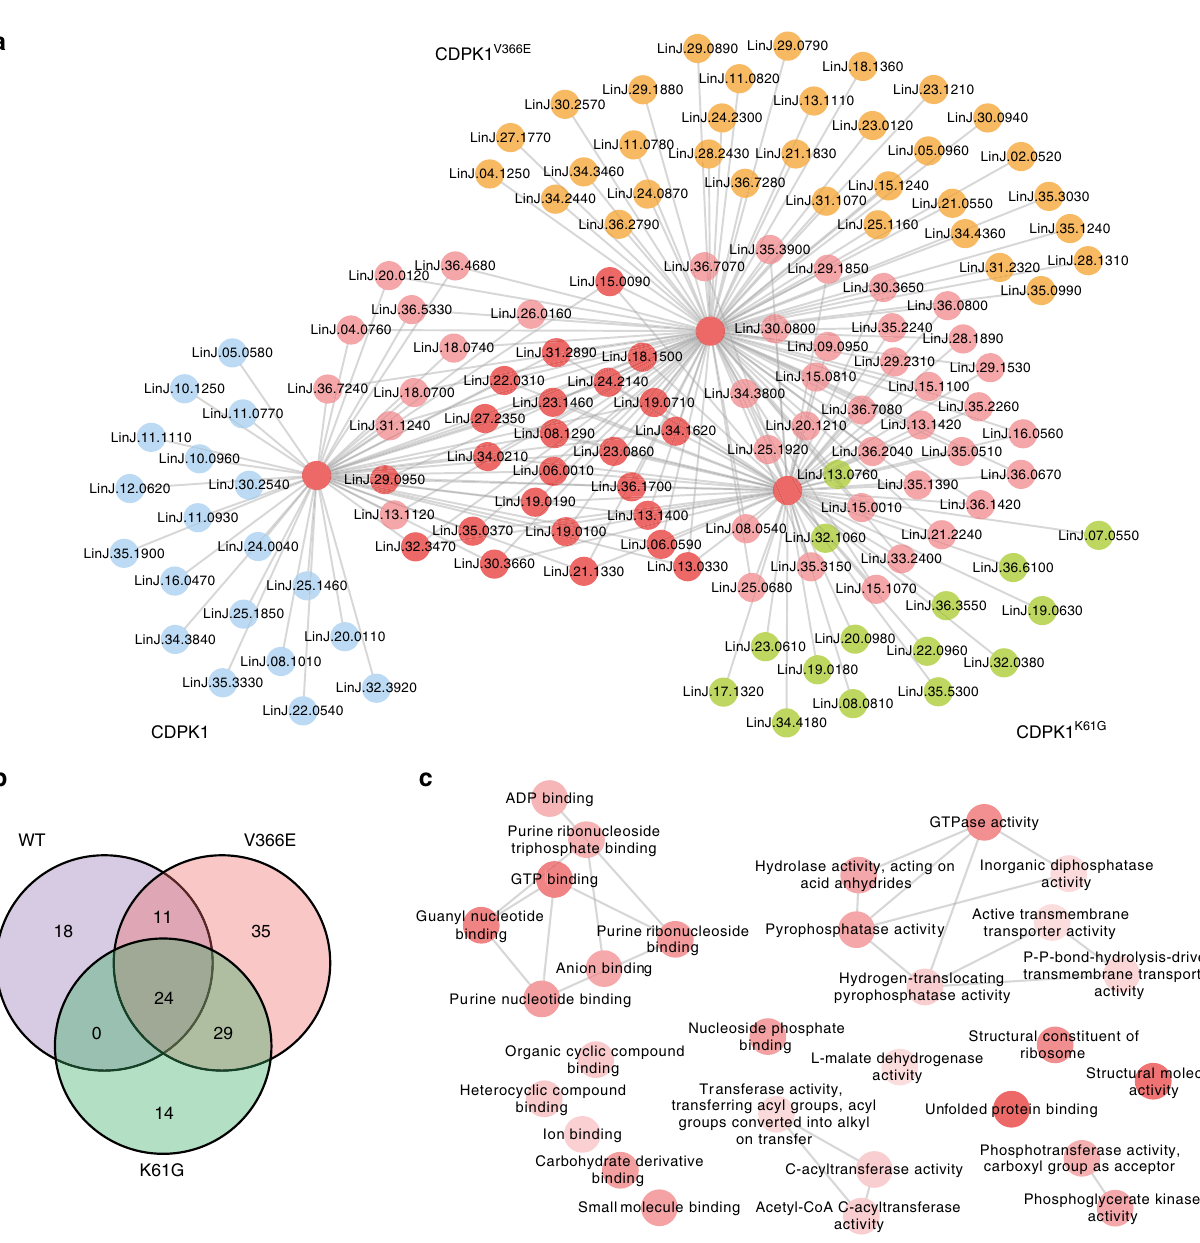
Fig. 5 CDPK1 interactome and candidate targets. a Nodes inferring speci fi c gene-IDs as retrieved from SAINT analysis (AvP> 0.8) of IP data for CDPK1- HA, CDPK1 K61G -HA and CDPK1 V366E -HA. Visualization of predicted interacting partners by Cytoscape. Independent IP experiments, carried out using HA- DHFR-TS and HA-PTR1 expressed episomally in L. infantum , were treated as controls. Test and control experiments were set in three biological replicates. SAINT analysis was performed using total spectral counts for peptides identi fi ed with <1% FDR. The networks were merged using DyNet analyzer. Unique nodes are presented in orange, green and blue respectively for CDPK1 V366E -HA, CDPK1 K61G -HA and CDPK1-HA. Common nodes are presented in shades of red depending on the level of overlap. An enlarged version of the three interactomes is shown in Supplementary Fig. 8. b Number of overlapped proteins identi fi ed by immunoprecipitation of the three CDPK1-HA versions is shown by Venn diagram. Lists of unique proteins associated with CDPK1 and proteins present in all samples are found in Supplementary Data 3. c Cytoscape visualization of network depicting signi fi cantly ( P < 0.05) over-represented GO- molecular function terms for the gene list generated by SAINT analysis of possible interactome for CDPK1. The network fi le was generated using REVIGO following analysis of the gene list for GO-enrichment using existing tools in TriTrypDB. Nodes represent speci fi c GO-MF terms and intensity of shades signify extent of enrichment for the